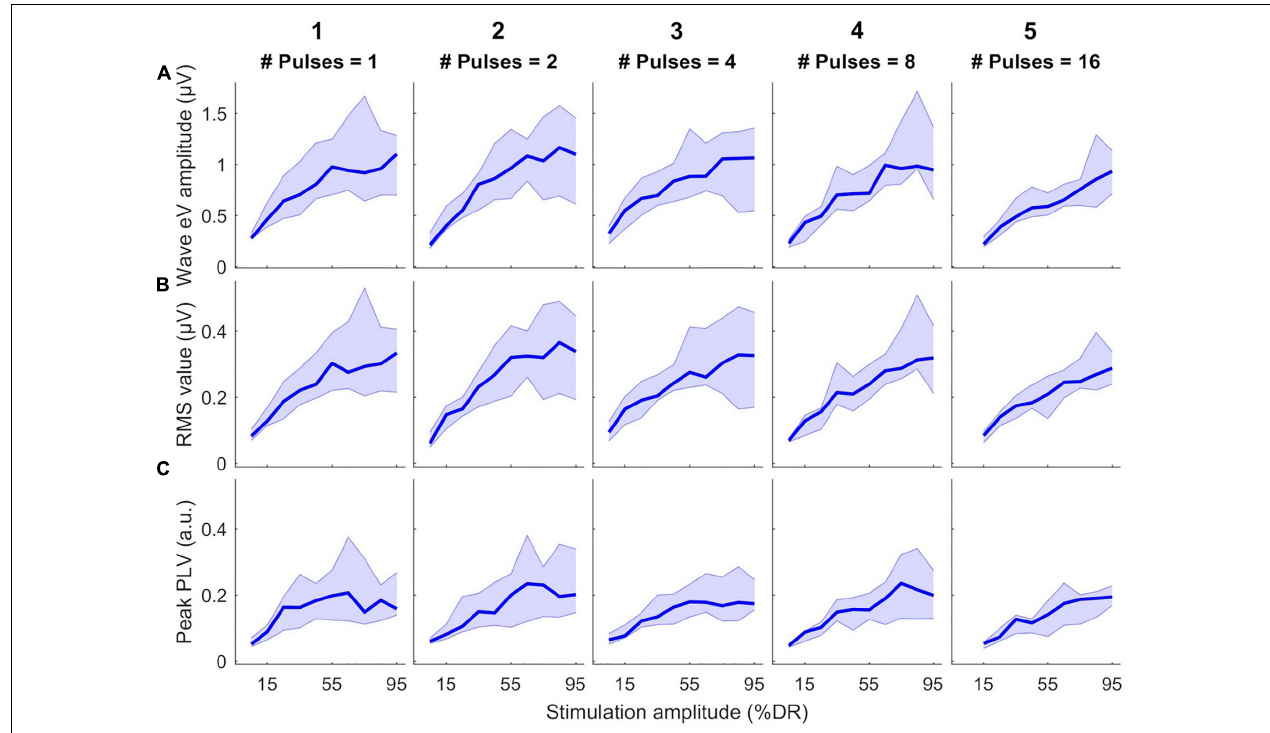
FIGURE 4 | Growth functions of features used to estimate eABR THRs as a function of stimulation amplitude (%DR) in all multiple-pulse (MP) conditions across all subjects. (A) Wave eV amplitude, (B) eABR RMS value, (C) Peak-PLV. Columns show growth functions of the features for specific MP condition. Thick lines show median values and shaded area represents the range between 25th and 75th